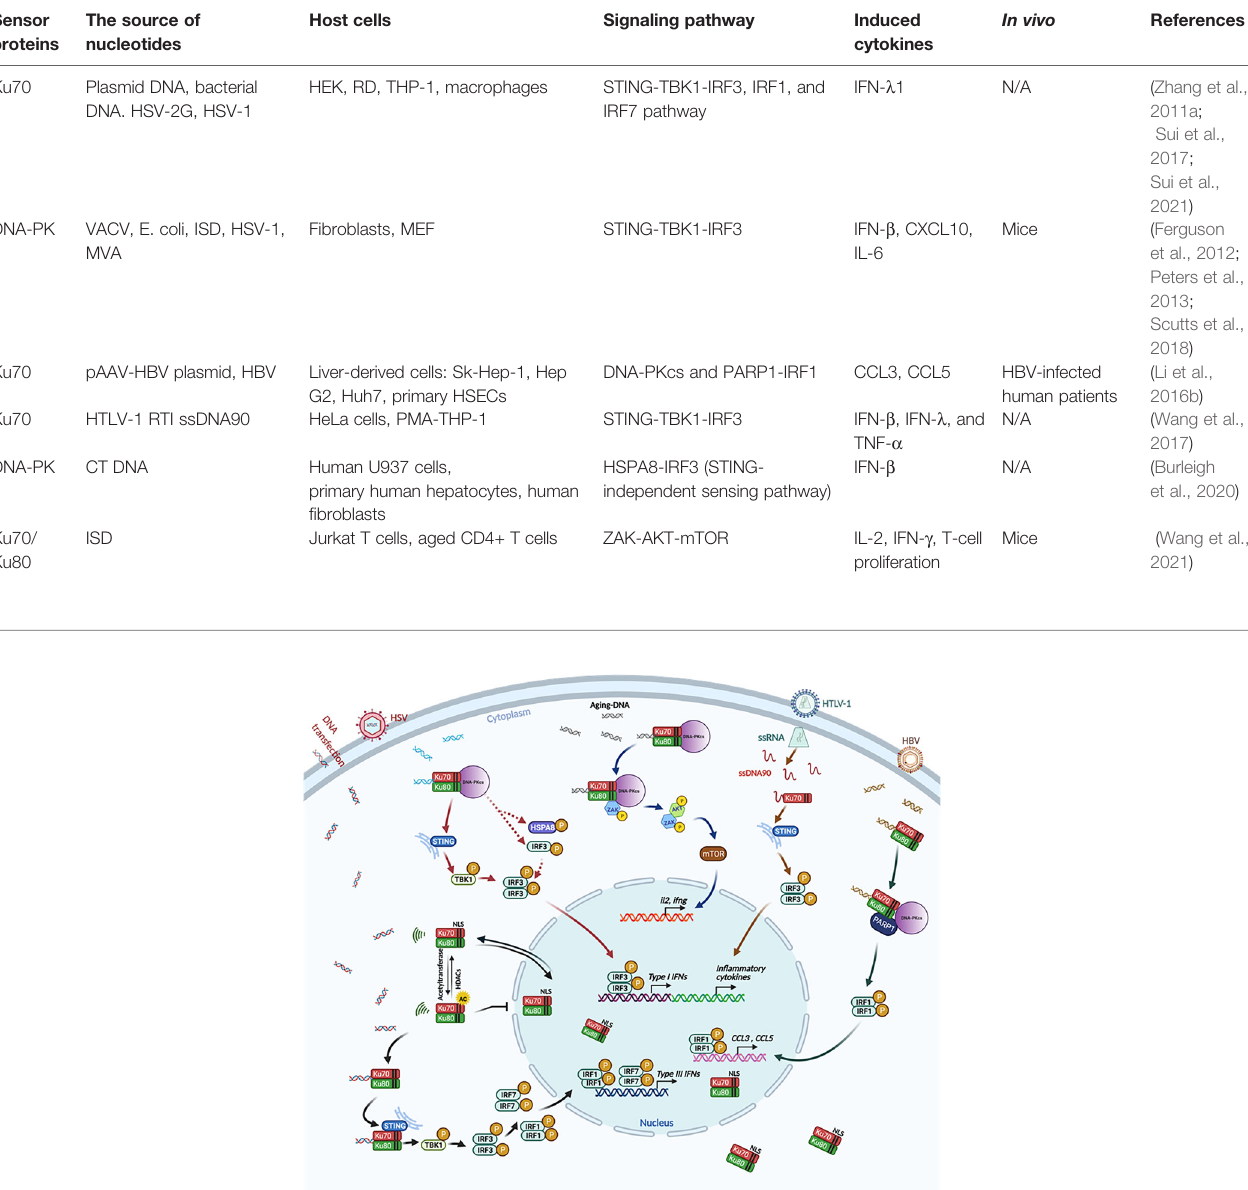
TABLE 1 | List of studies about Ku70-involved innate immune response.